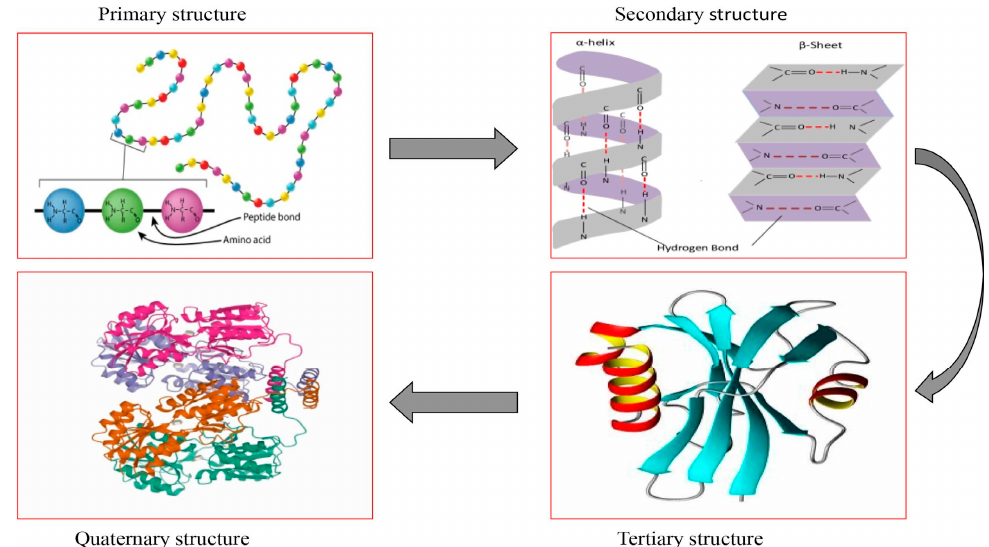
Figure 3. Sequential alterations in the primary, secondary, tertiary and quaternary structures of a protein exposed to ultrasonic treatment [58].